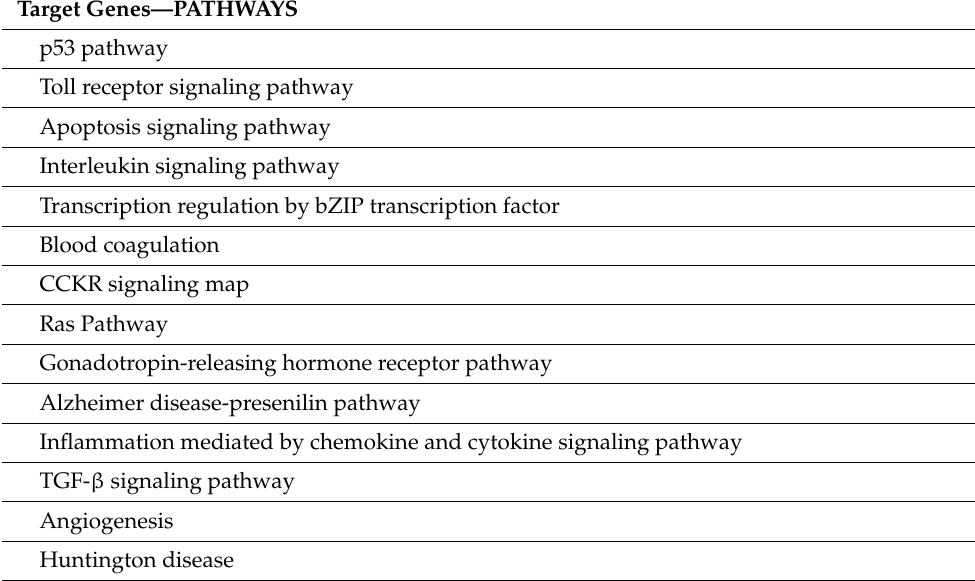
Table 4. Pathway overrepresentation of 626 targets of TFs and RBPs with a correlation with NAPRT expression and miRNA targets. Only the child terms relative to 10 or more genes and with a fold enrichment of over 3 are presented by decreasing fold enrichment order. Complete results are in Supplementary Table